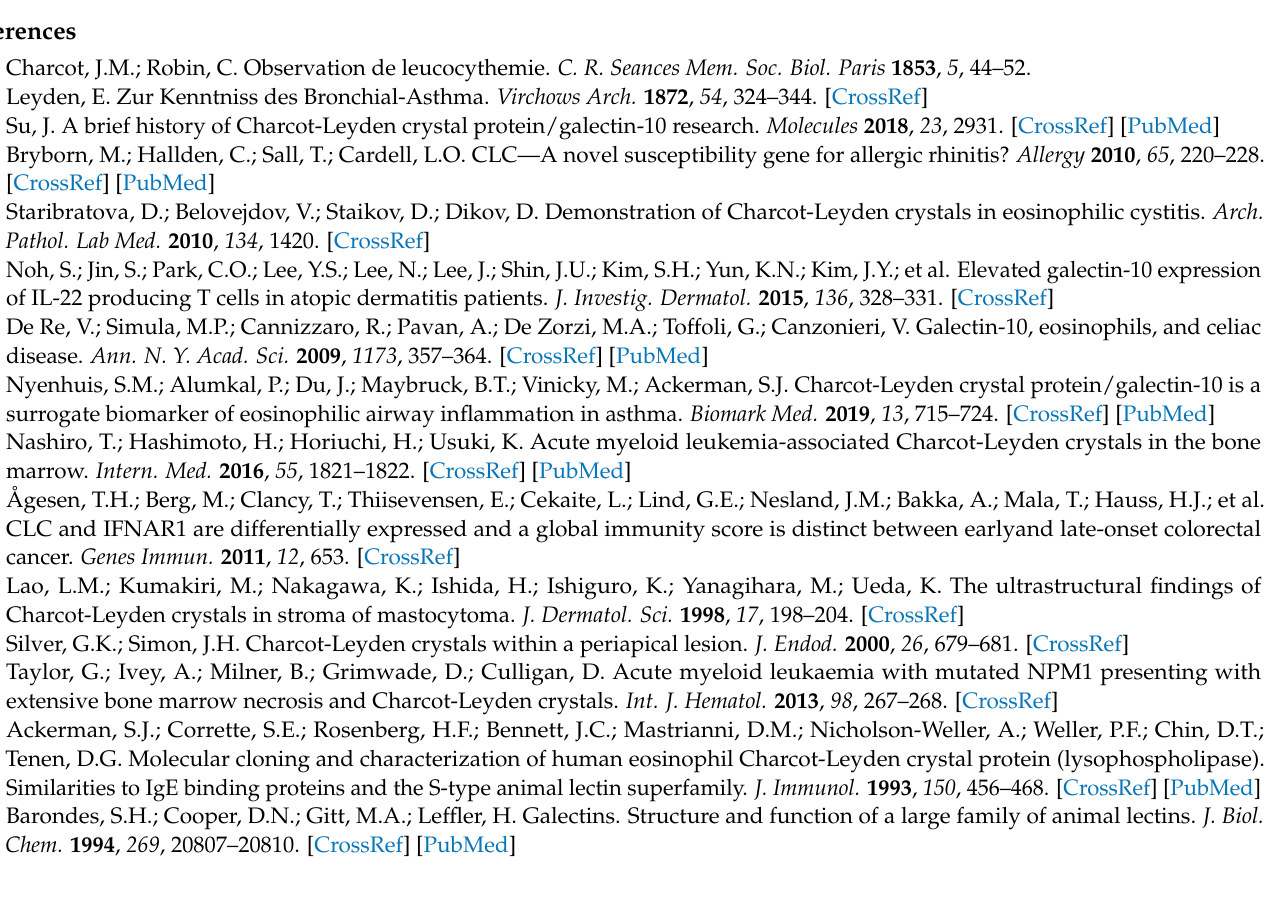
SEC, Figure S2: SEC HPLC of Gal-10 and myoglobin, Figure S3: Native PAGE of Gal-10 monomers and dimers, Figure S4: Effect of galactose on crystallization of Gal-10 proteins without His-tag, Table S1: Quantitative data (percentages) of Gal-10 monomers and dimers as shown in Figure